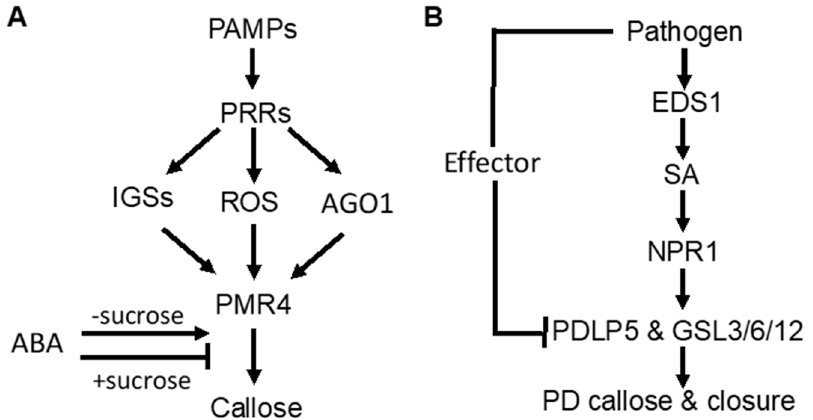
Figure 1. Signaling of pathogen-induced callose deposition in plants. ( A ) pathogen-associated molecular pattern (PAMP)-induced callose deposition is mediated by pattern-recognition receptors (PRRs) and promoted by indole glucosinolates (IGSs), reactive oxygen species (ROS), and RNAi regulatory protein Argonaute1(AGO1). ABA stimulates but represses PAMP-induced callose deposition in the presence of high sucrose concentrations. ( B ) pathogeninduced callose deposition in plasmodesmata (PD) through the SA-mediated signaling pathway.